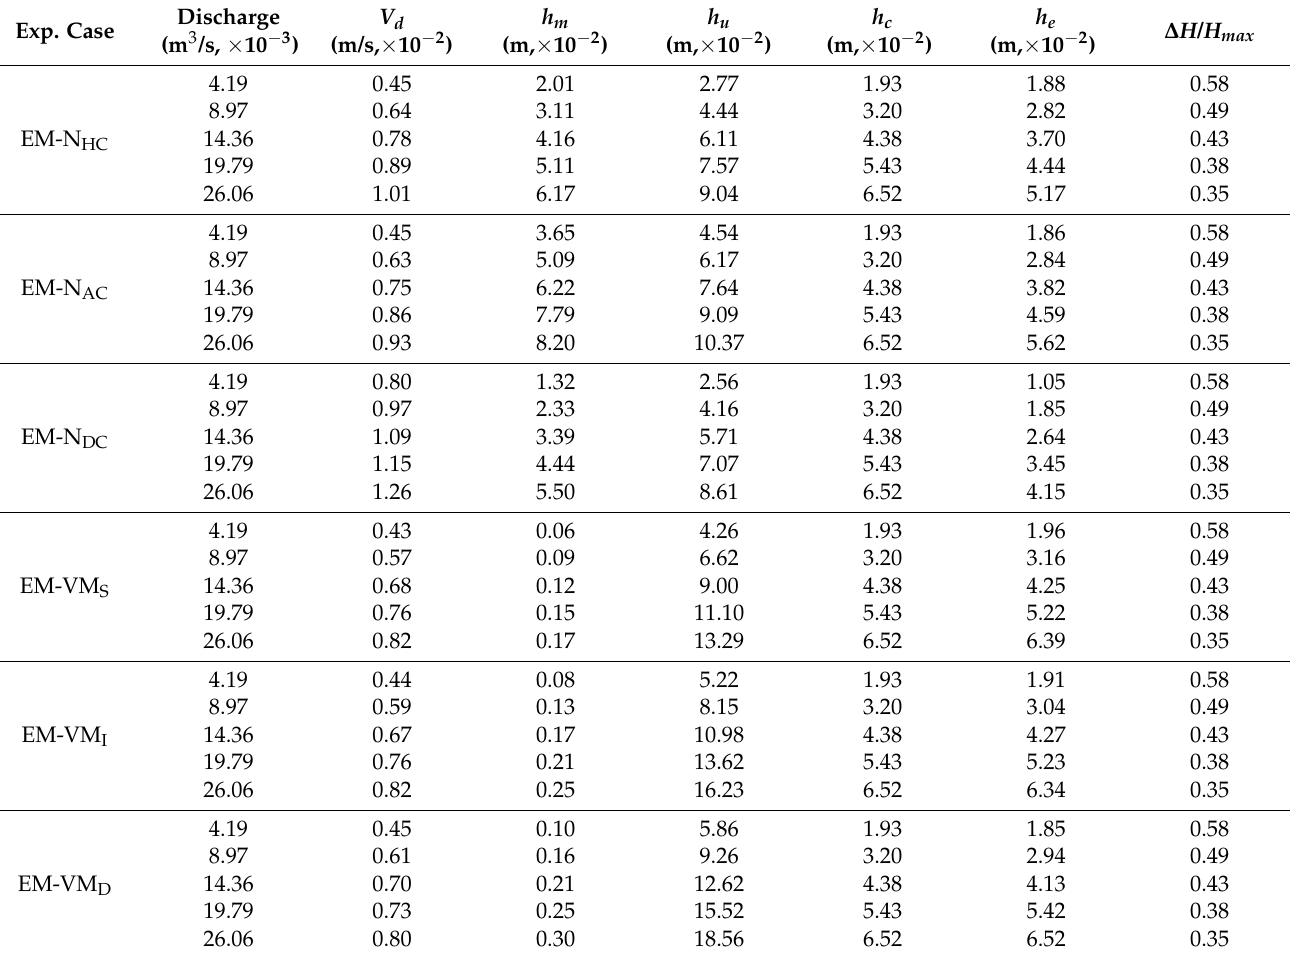
Table 3. Summary of the experimental conditions used in each experimental